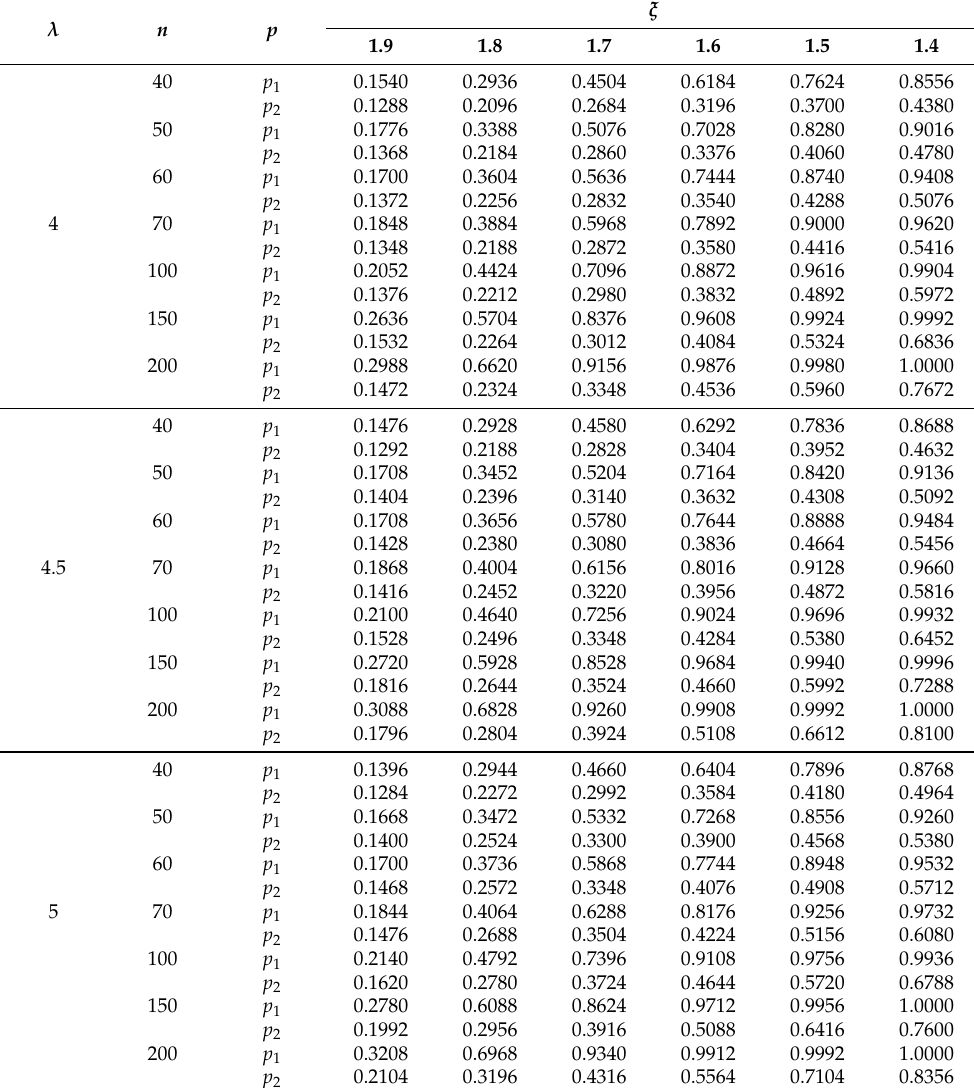
Table A2. Simulated powers of hypothesis testing problem (19) (positive